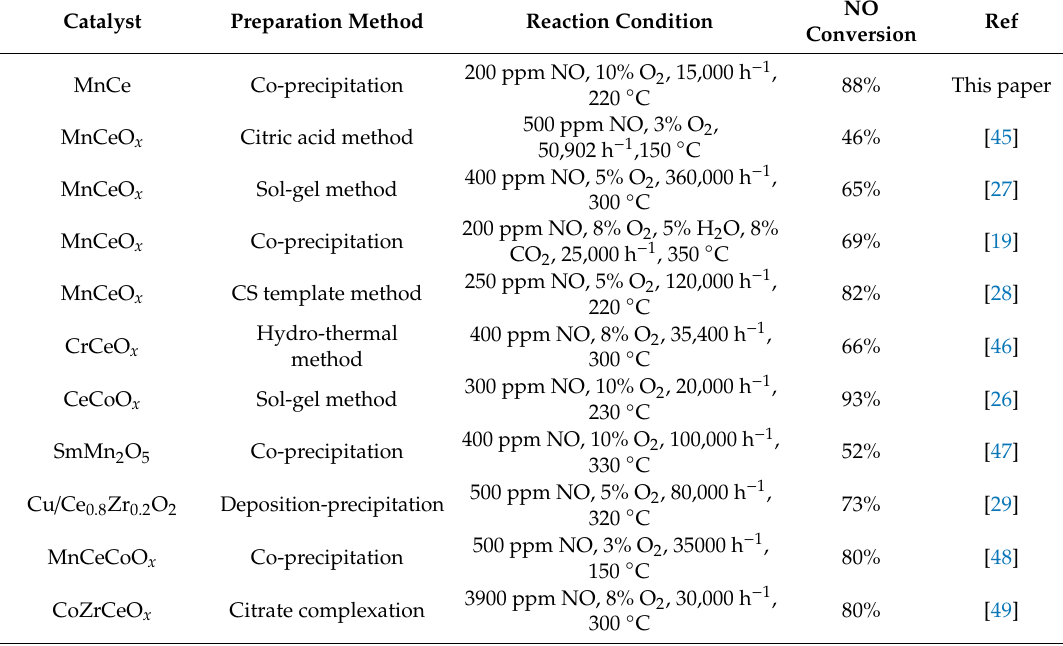
Figure 4. NO conversion over MnO x -CeO 2 with different calcination temperature. Table 6. Summary of the metal oxides catalytic activities in literatures.